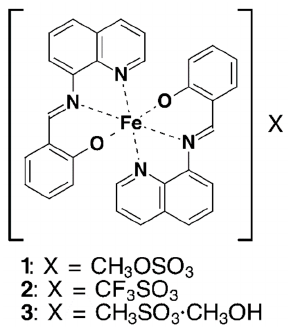
Figure 1. Molecular structures of compounds 1 − 3 .